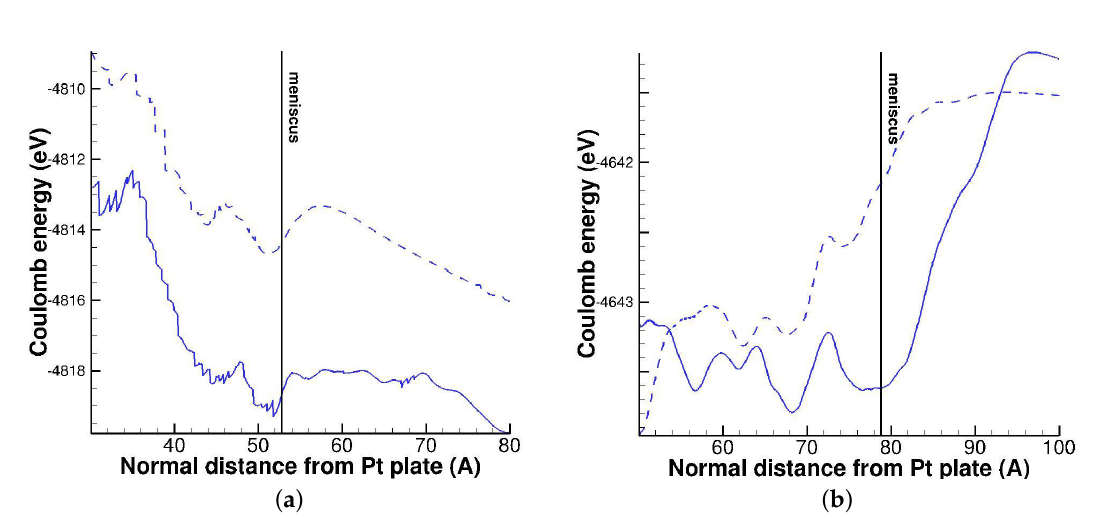
Figure 8. The Coulomb energy of 1000 ion pairs is shown, such that the solid and dashed lines represent the case when the entire cation-anion and when only the cation were moved towards the cathode, respectively. An extrusion electric field of 8 and 3 V/nm was assumed for EAN and EMIM-BF 4 , respectively. ( a ) EAN; ( b ) EMIM-BF 4